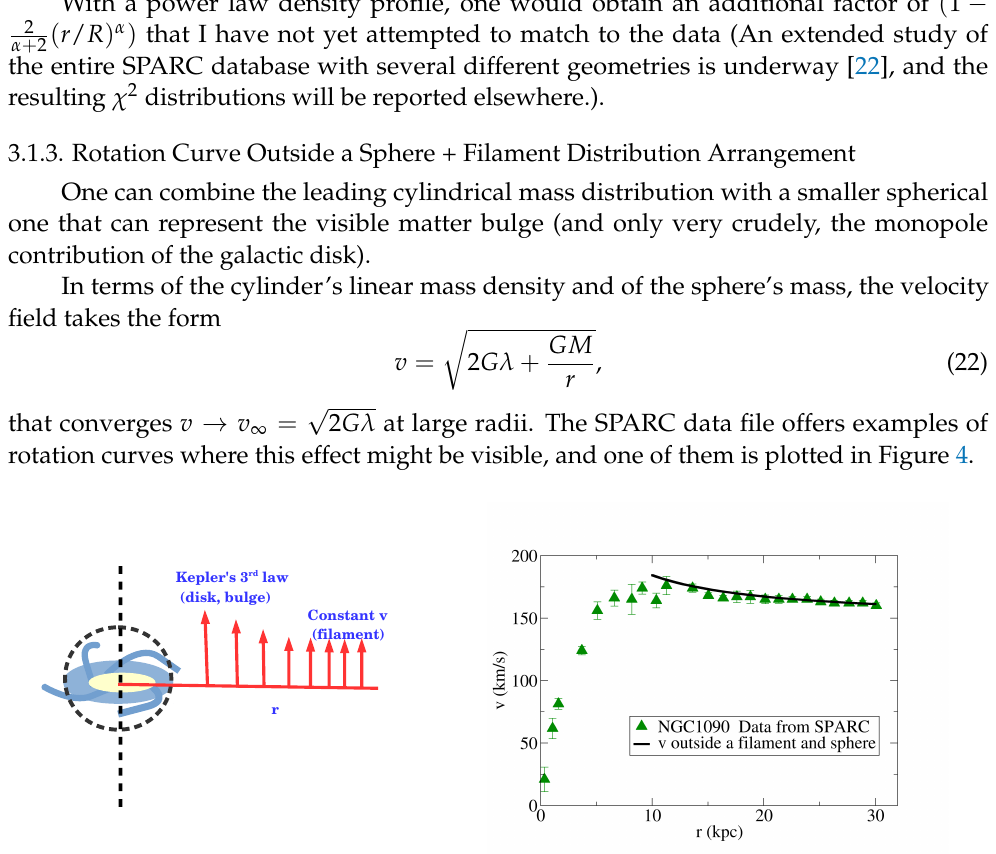
Figure 3. A linear rise out to a radius R given by Equation (21), followed by a flat v ∞ = is a reasonable first approximation to numerous spiral galaxy rotation curves, and follows from a finite-sized cylinder of uniform density. Of course, edge effects or other density profiles could be included in extensive studies.